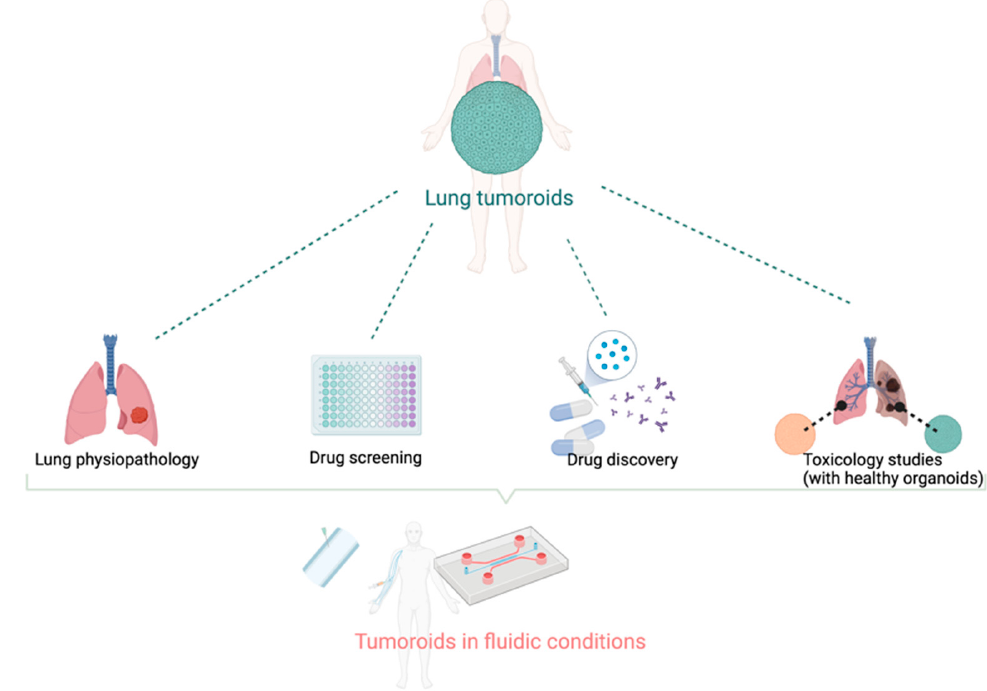
Figure 1. The variety of applications for tumoroids and organoids models . Directly derived from patient biopsy or surgery, synthetic tumor models can be used to study tumorigenesis, tumor growth, and interactions with the normal tissues. The drug discovery process should benefit from higher predictivity from these models than current preclinical models. The combination with microfluidic systems allows for better mimicry of the tumor dynamics and makes these tumor models suitable with high throughput/high content bioassays. Created with BioRender.com.